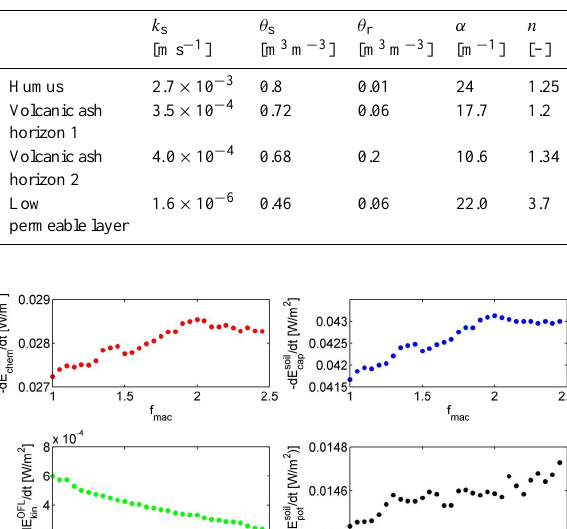
Table 2. Laboratory measurements of average hydraulic proper- ties for typical Malalcahuello soils (after van Genuchten, 1980, and Mualem, 1976). Saturated hydraulic conductivity k s , porosity θ s , residual water content θ r , air entry value α , shape parameter n .